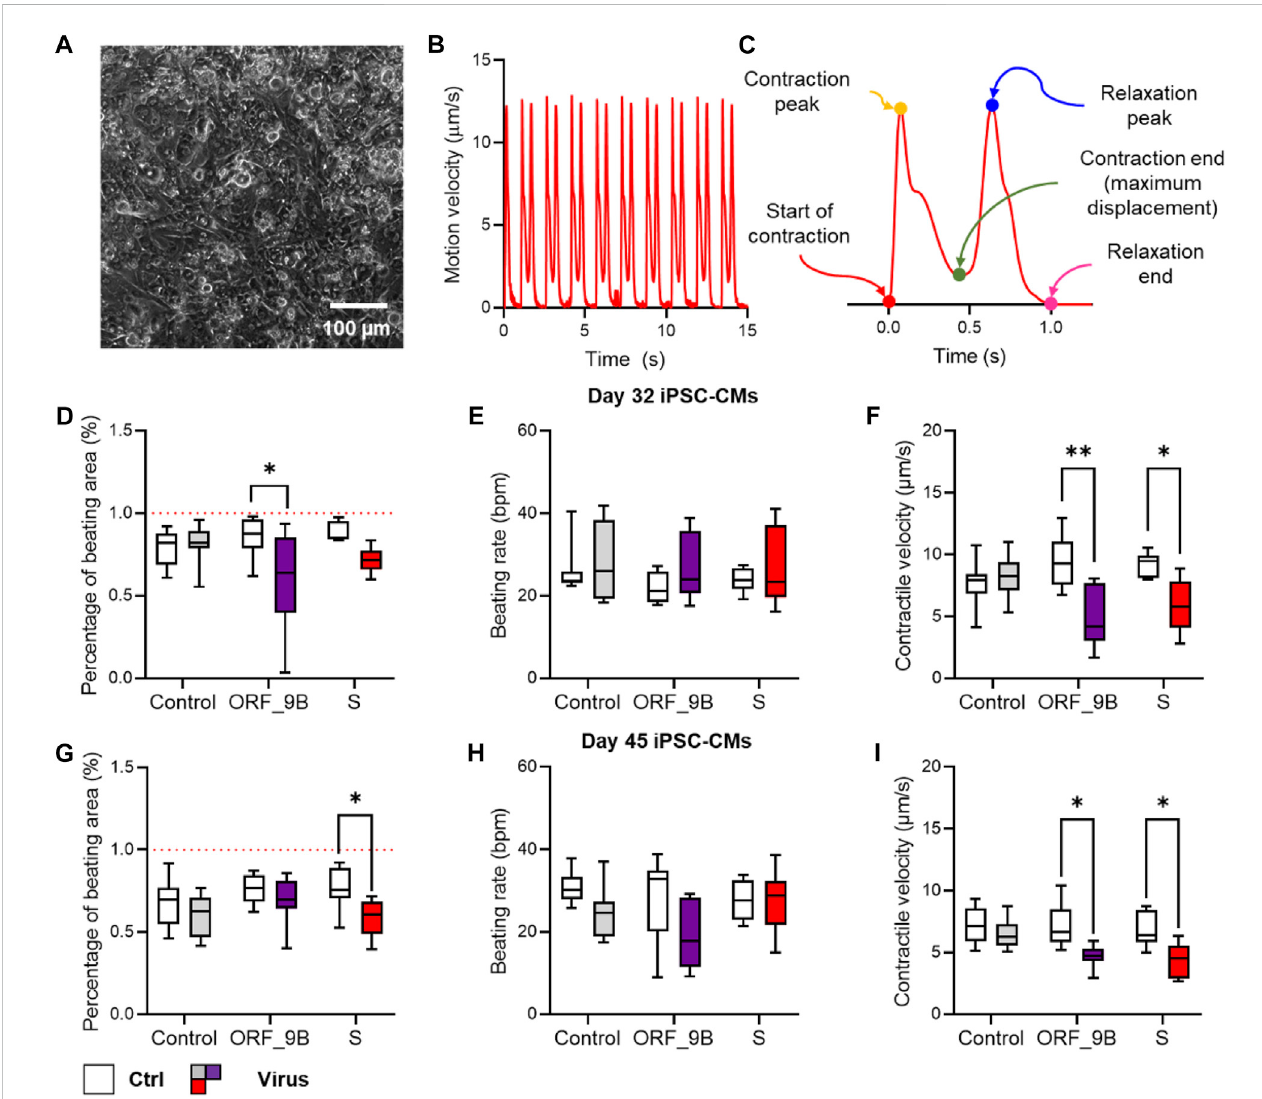
Screening of the impact of SARS-CoV-2 subunits in CMs with contractility assay. (A) Phase contrast image of monolayer CMs plated for contractility assay. (B) Typical trace of the average displacement velocity generated by frame-to-frame displacement analysis. (C) Averaged motion peaks showing the start,peak,andendofcontractionandrelaxation,allowingdetailedanalysisofcontractileandrelaxationvelocityandduration. (D – F) Functionalmeasurement of the percentage of beating area (D) , beating rate (E) and contractile velocity (F) in CMs before (control) and after (virus) over-expression of COVID proteins by lentiviral vectors. (G – I) Functional measurement of the percentage of beating area (G) , beating rate (H) and contractile velocity (I) in CMs on day 30 before (control) and after (virus) overexpression of COVID proteins by lentivirus vectors. N > 8 wells of CMs from at least two independent experiments in each group. * and **: p < 0.05 and p < 0.01 vs. non-virus controls from the same group of COVID-19 experiment in two way-ANNOVA followed by Sidak ’ s multiple